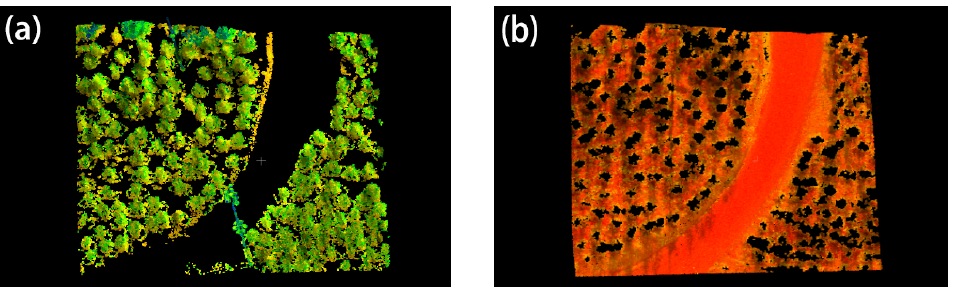
Figure 22. The point clouds of the Figure 20 is segmented according to the intensity: ( a ) is the non-ground points; ( b ) is the ground points.